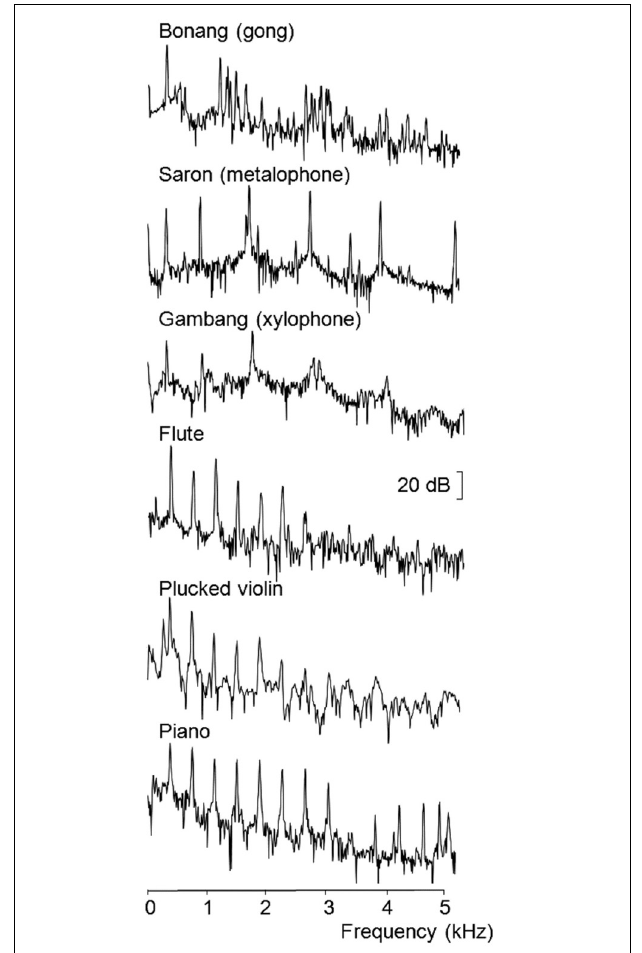
FIGURE 1 | FFT spectra recorded for the lowest frequency example of each instrument type (Hamming window over 4096 samples from sound onset at 44.1kHz sampling